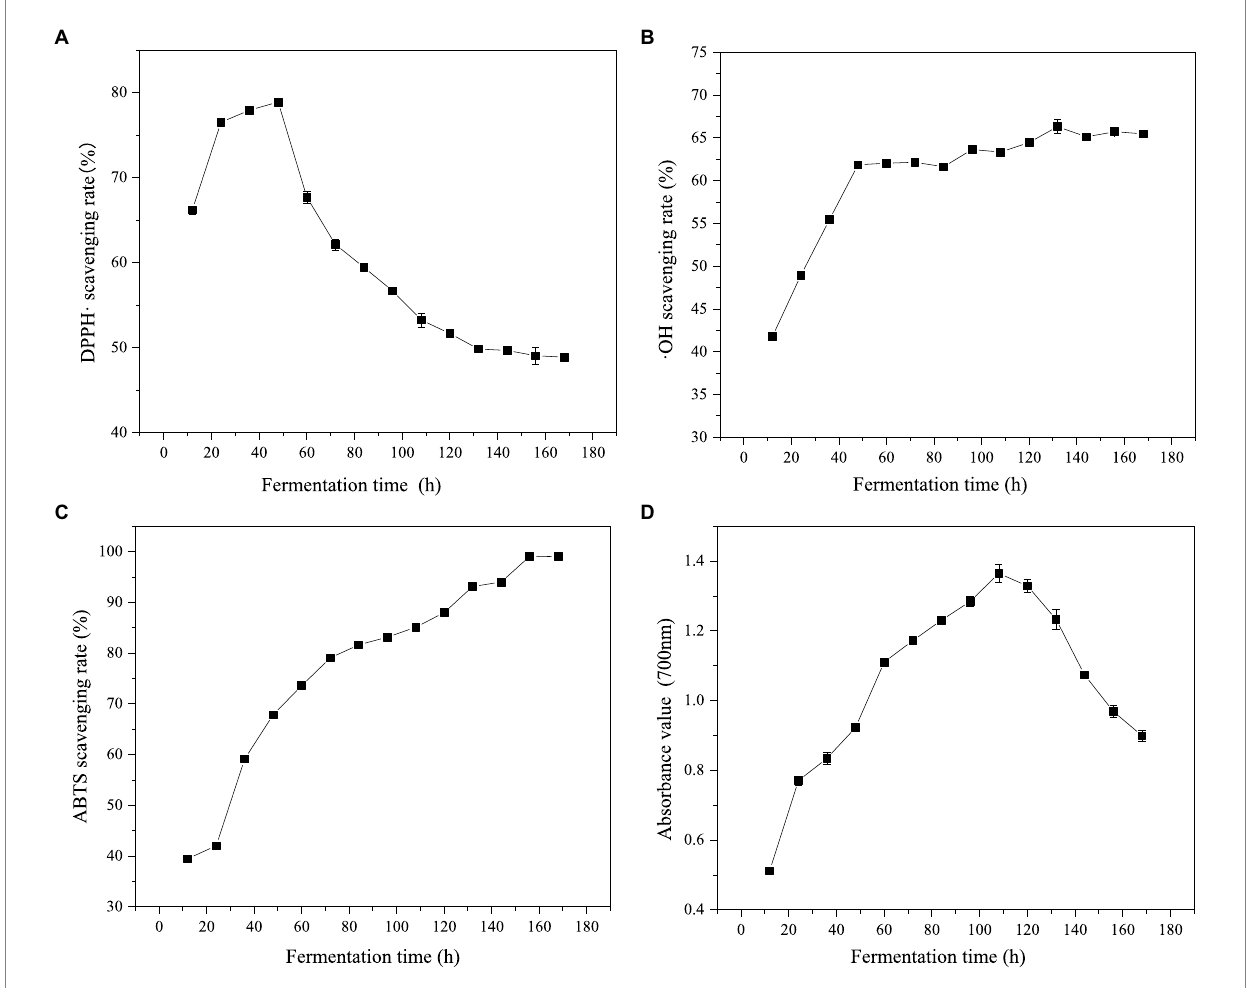
FIGURE 4 Effects of different fermentation time on DPPH·, ·OH, ABTS scavenging rate and iron-reducing power. (A) Effects of different fermentation time on DPPH· scavenging rate. (B) Effects of different fermentation time on ·OH scavenging rate. (C) Effects of different fermentation time on ABTS scavenging rate. (D) Effects of different fermentation time on iron-reducing